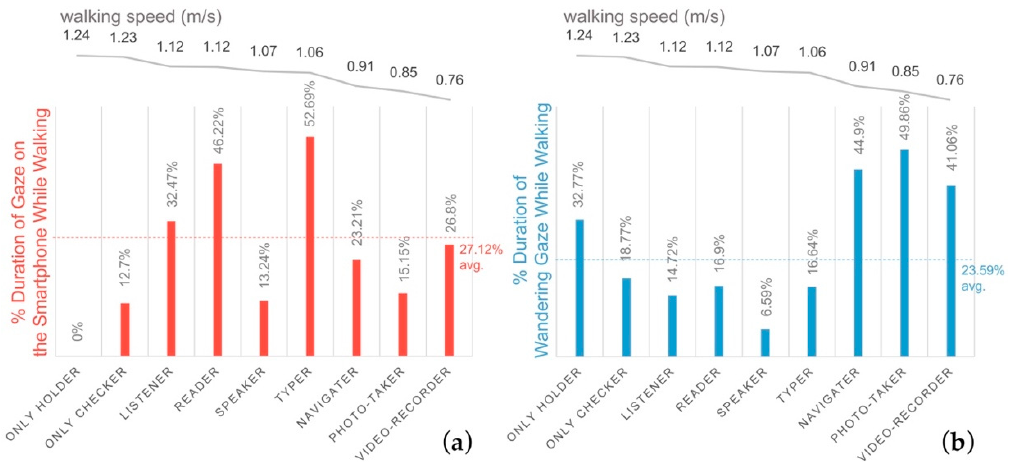
Figure 6. Mean percentages of ( a ) gaze on the smartphone screen and ( b ) wandering gaze while walking, and the mean walking speed for each smartphone activity.